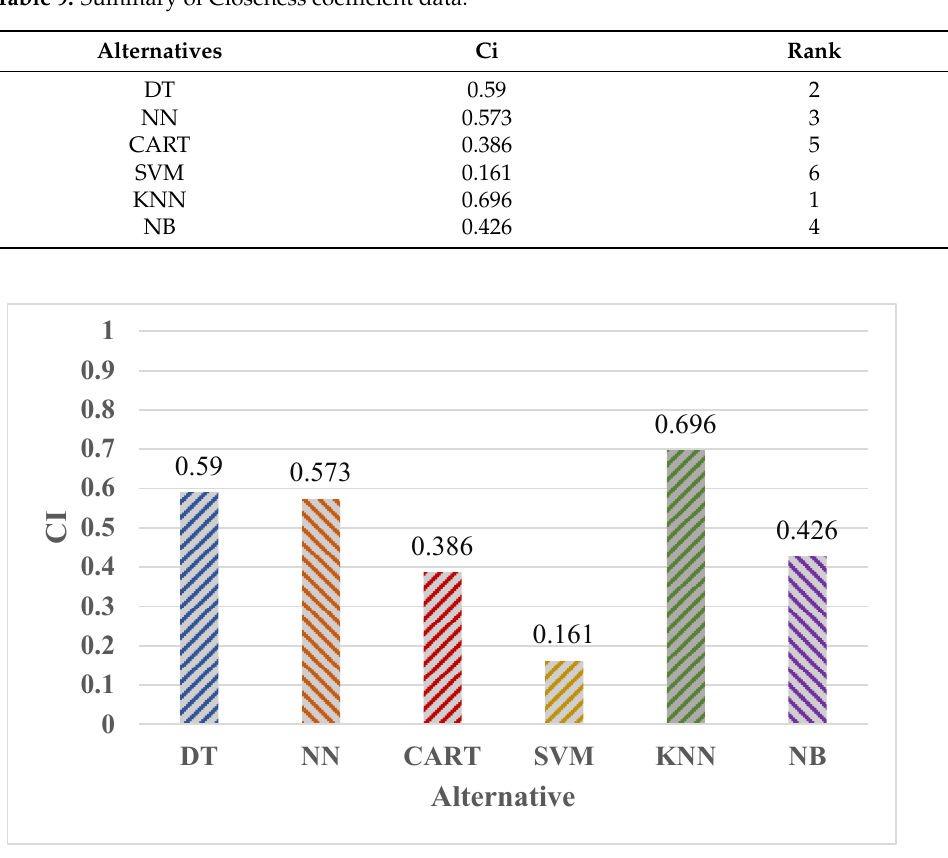
Figure 5. Closeness coefficient of each alternative.